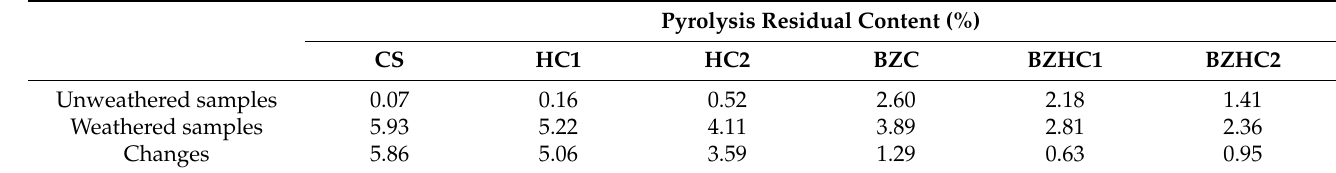
Figure 7. The TGA curves of unweathered and weathered samples. Table 4. Pyrolysis residual content of unweathered and weathered